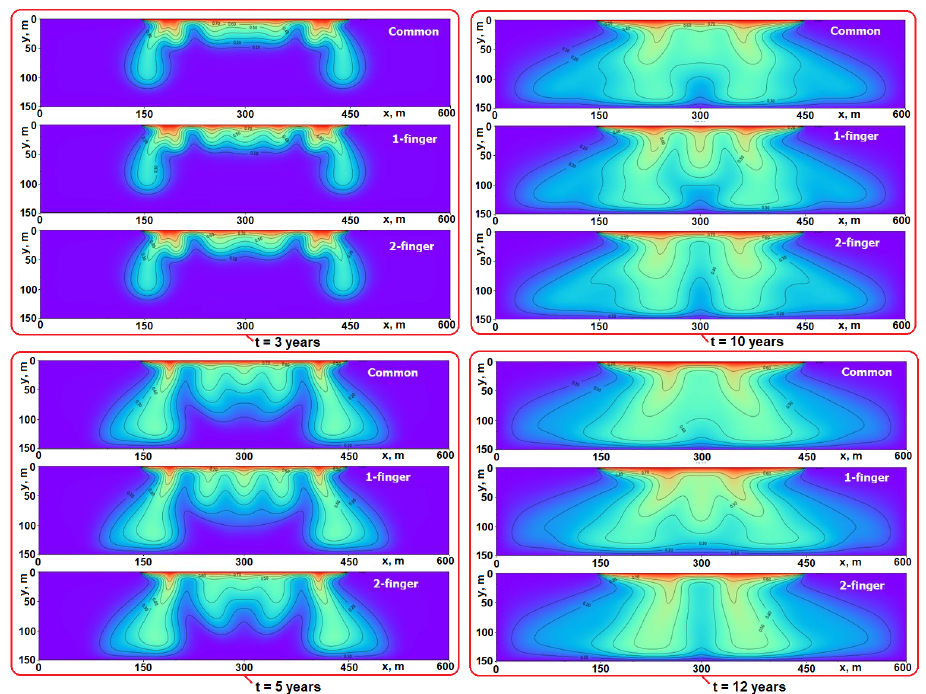
Figure 11. Average solutions at t = 3,5,10,12